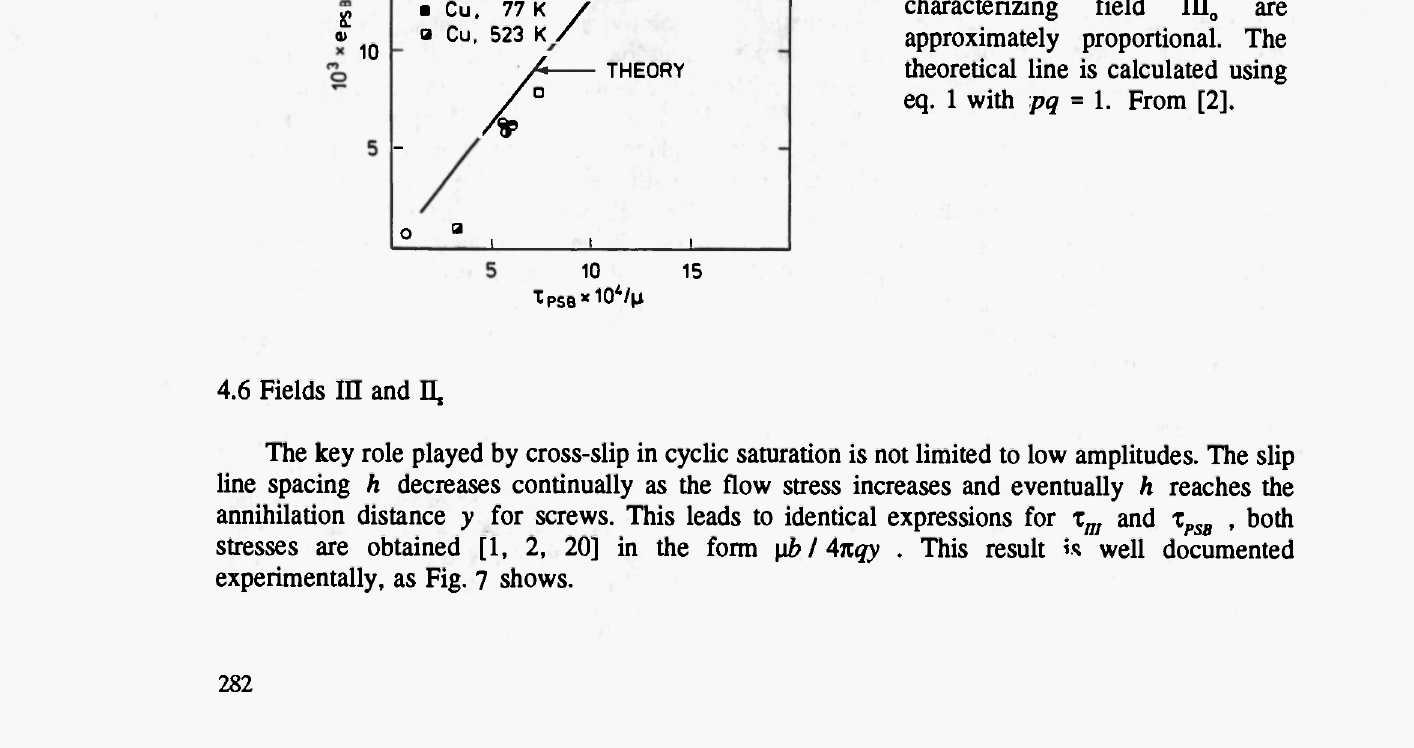
ρ PSB psB are 0